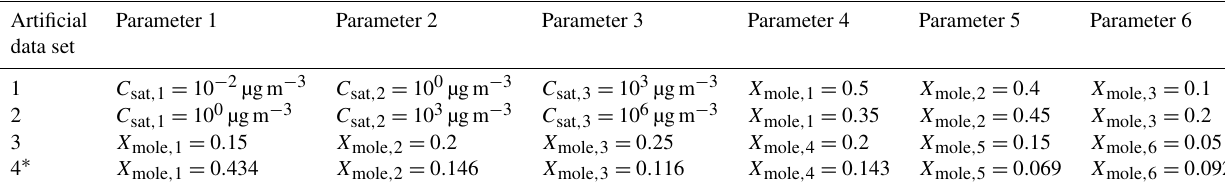
Table 3. The correct parameters that are fitted in the optimization process for every artificial data set. The order of the mole fractions is from the least volatile to the most volatile compound for artificial data sets 3 and 4.